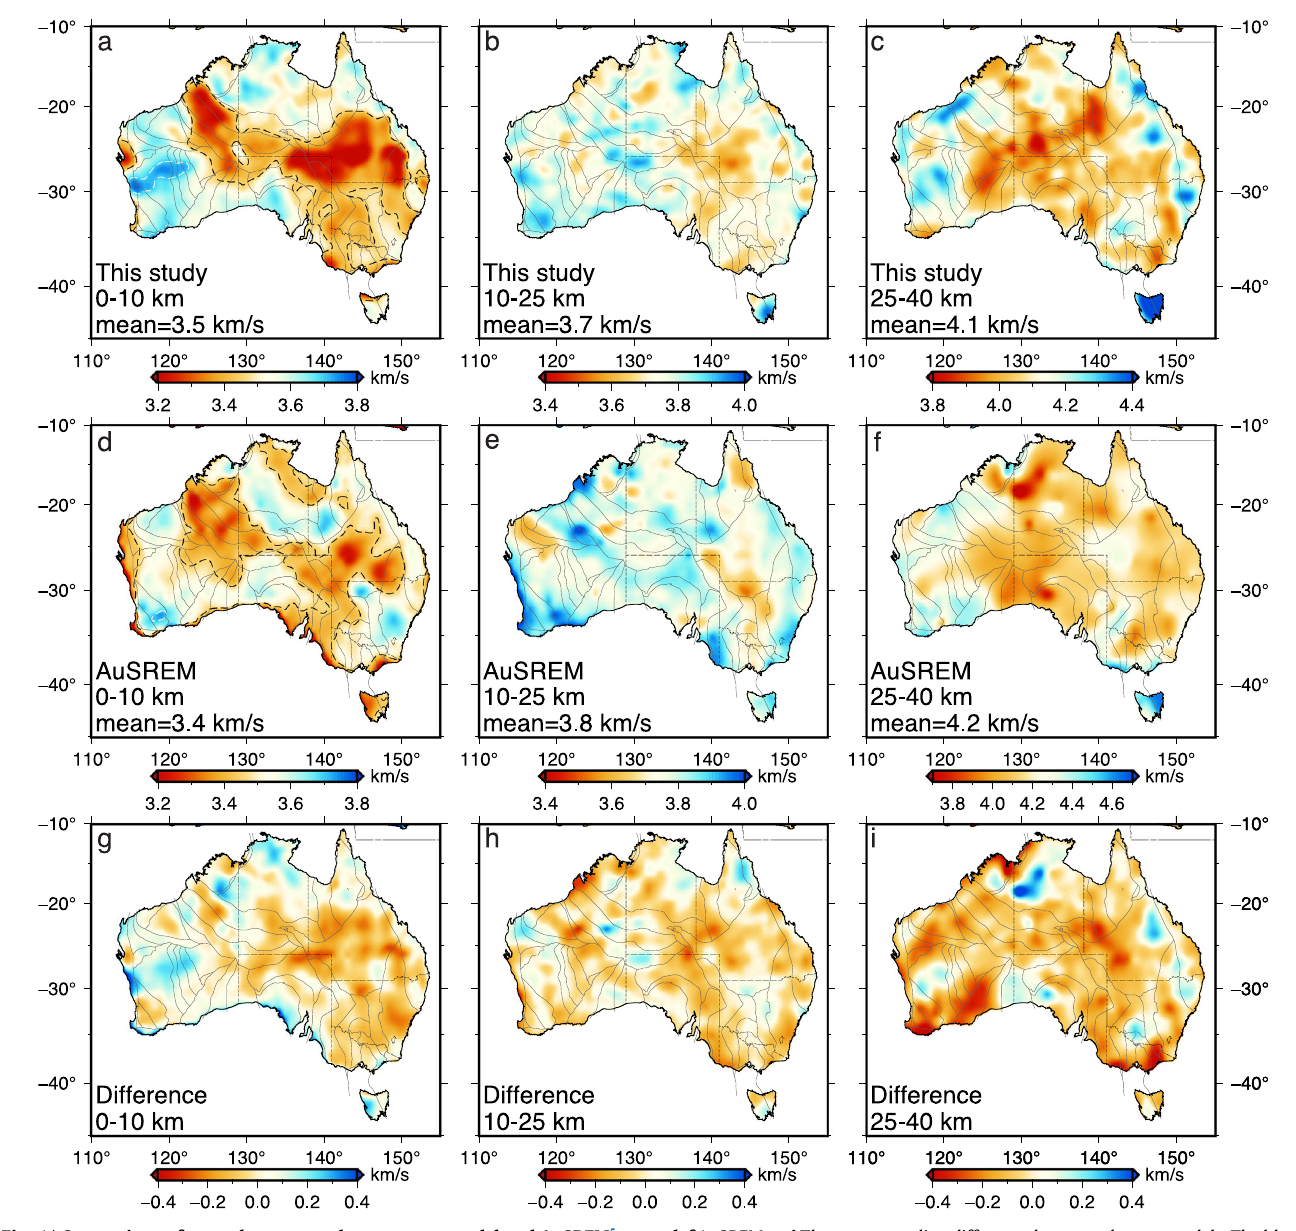
Fig. 6 | Comparison of crustal structures between our model and AuSREM 5 . Averageshearvelocitiesoftheupper,middle,andlowercrustin a – c ourmodeland